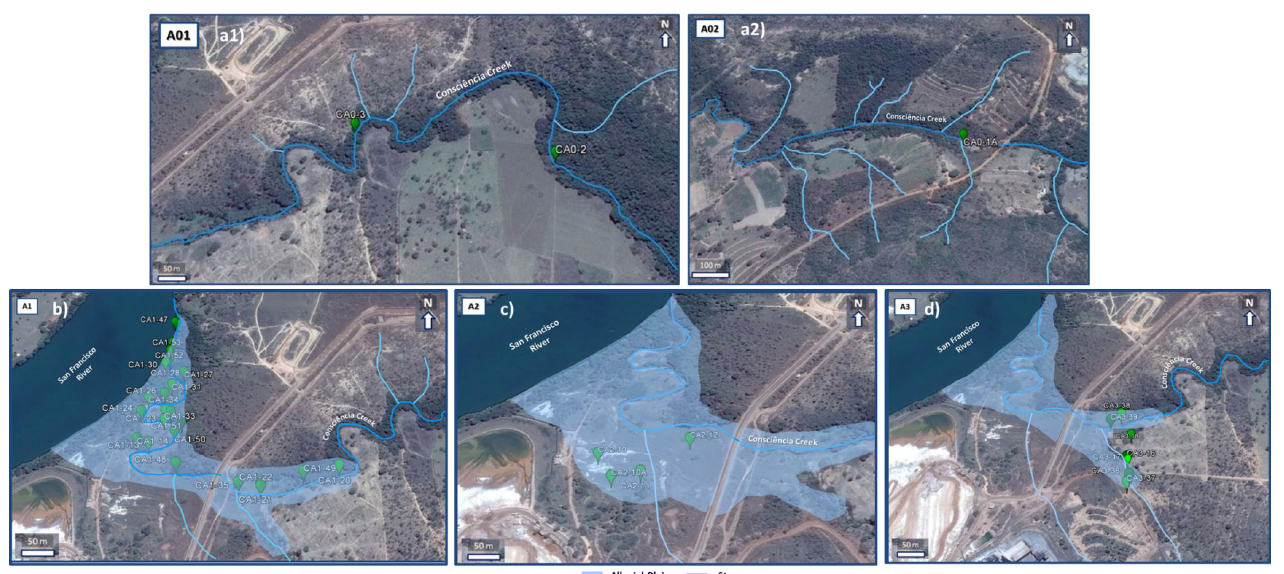
Figure 3. Location of the sampling points in the four selected areas. ( a 1) and ( a 2) correspond to the background area, ( b ) correspond to the A1 area, ( c ) correspond to the A2 area and ( d ) correspond to the A3 area.